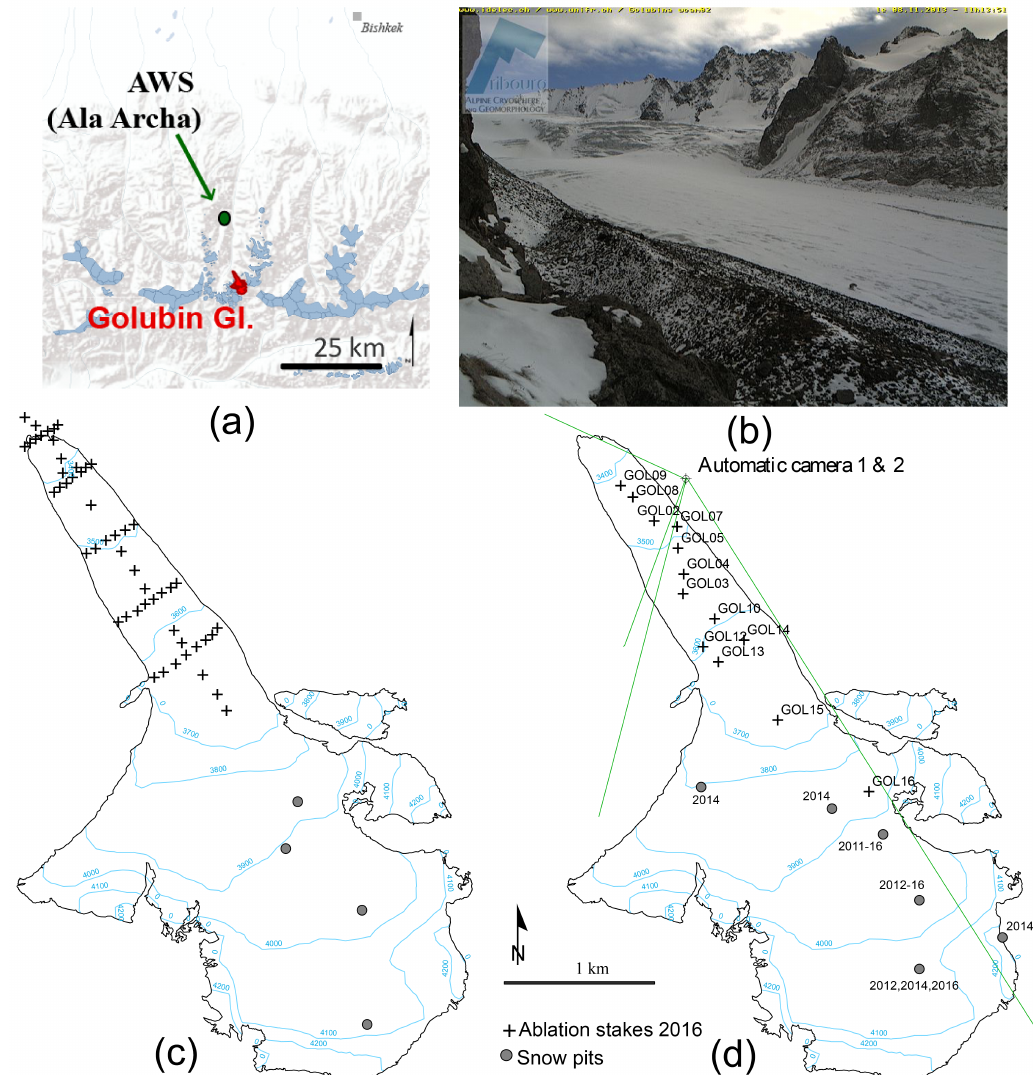
Figure 8. Historical (c) and new (d) mass balance network on the Golubin glacier (Kyrgyzstan) with corresponding (overview) map (a) and snow line camera picture (b)